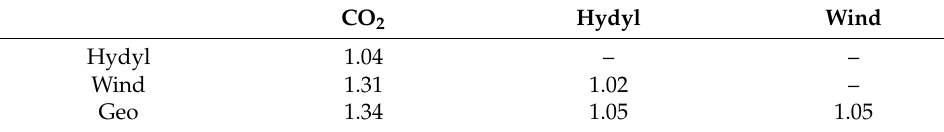
Table 3. Variance inflation factor (VIF Matrix) testing multicollinearity).